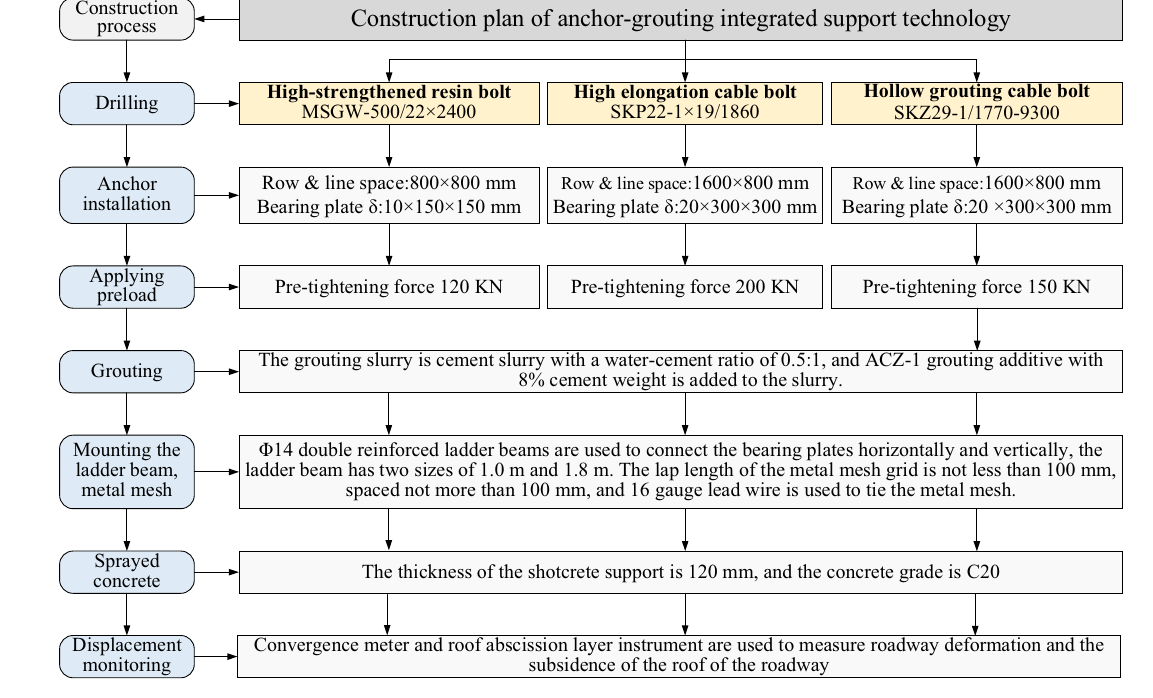
Fig. 25 Flow chart of construction of strengthening support